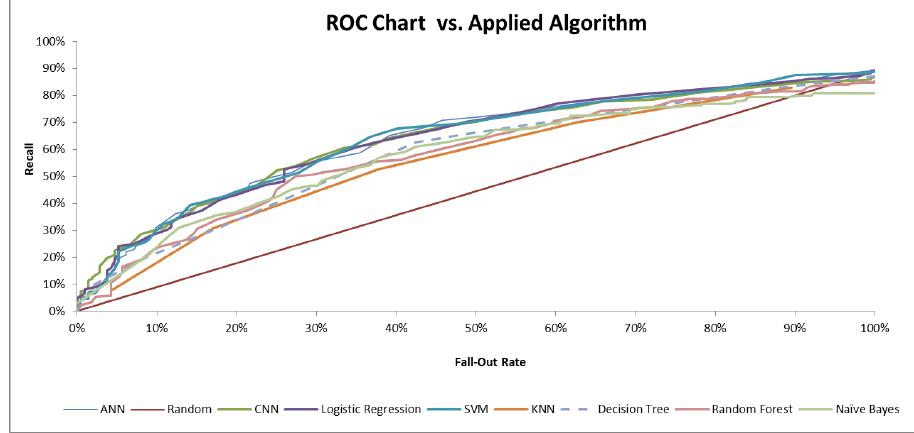
Figure 9. The ROC chart for NPS classification problem.